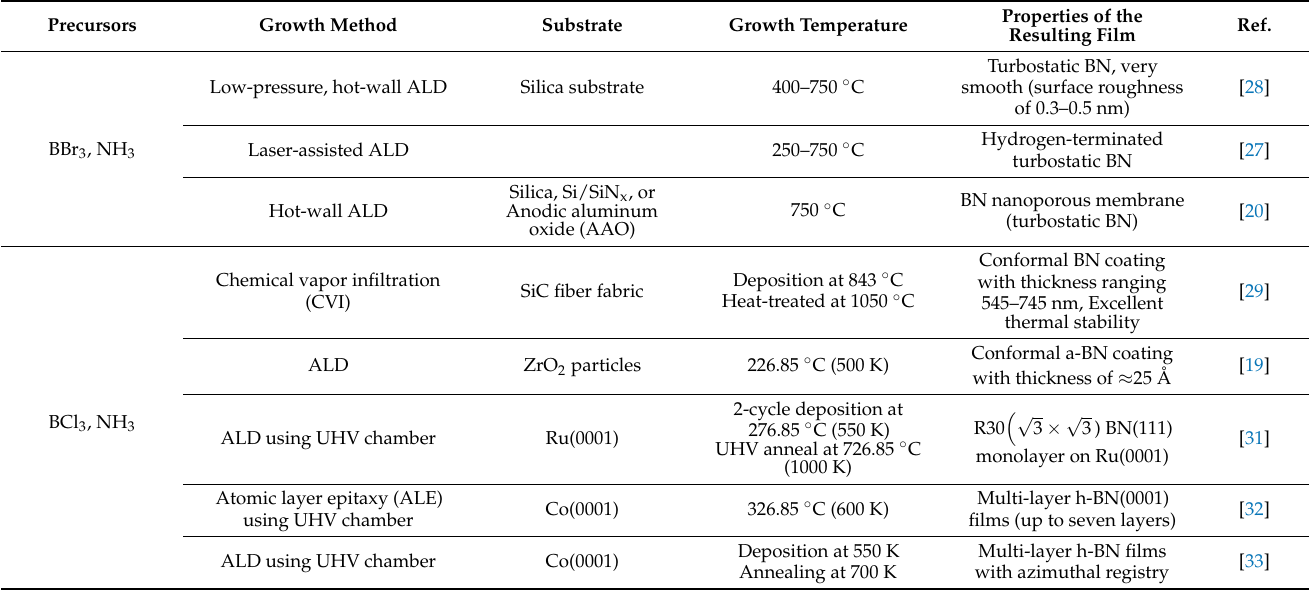
Table 1. Synthesis of BN from industrial gas